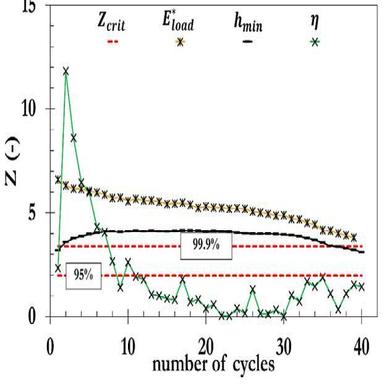
Evolution with cycles of the parameter Z for the comparison between neat polymer and composite core mean values of instantaneous elastic modulus (\), residual depth (-) and energy ratio (×) and of Zcrit for an interval of confidence of 99.9% (upper red dashed line) and 95% (lower red dashed line).